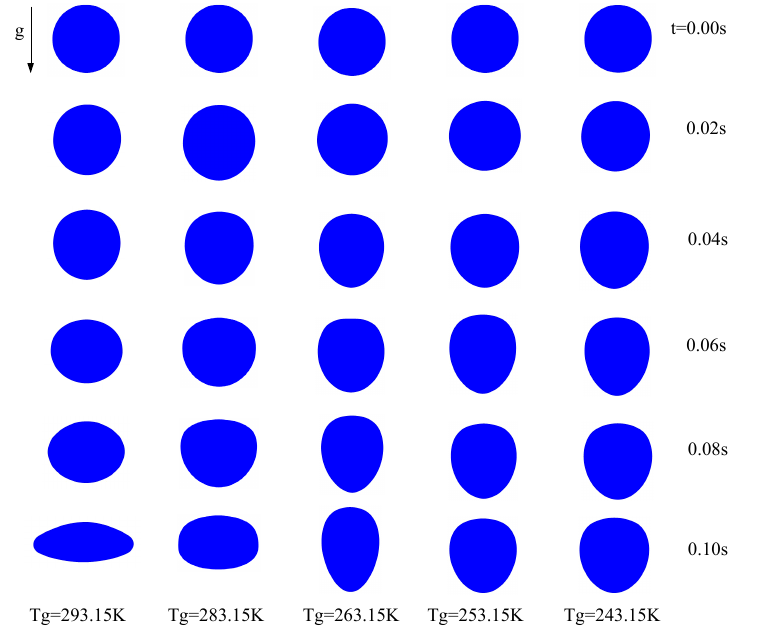
Figure 3. Deformation shape of free-falling water droplets at different temperatures. Table 2. Deformation factor A of a falling water droplet (10 − 4 ).